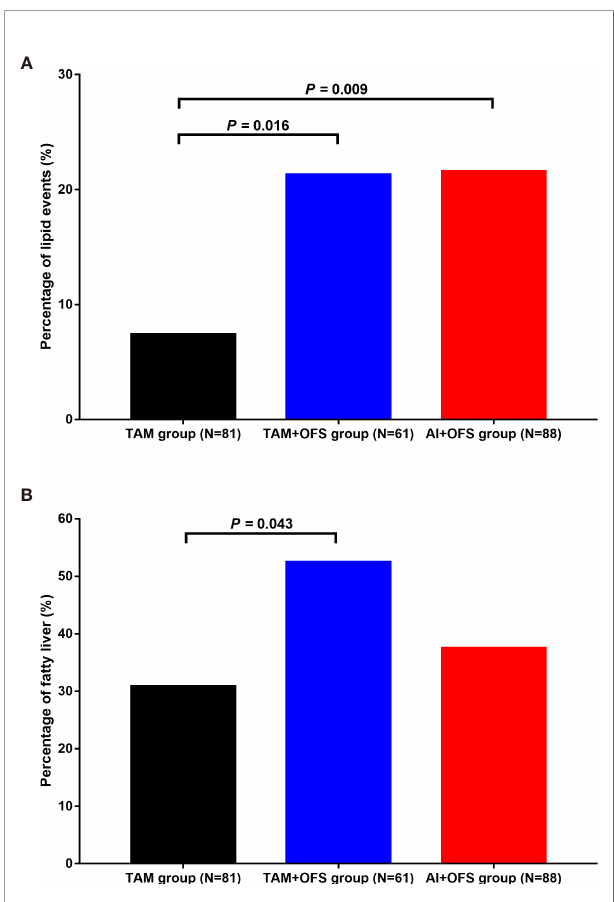
FIGURE 1 | Incidence of lipid events (A) and fatty liver (B) in different groups. TAM, tamoxifen; OFS, ovarian function inhibitor; AI, aromatase